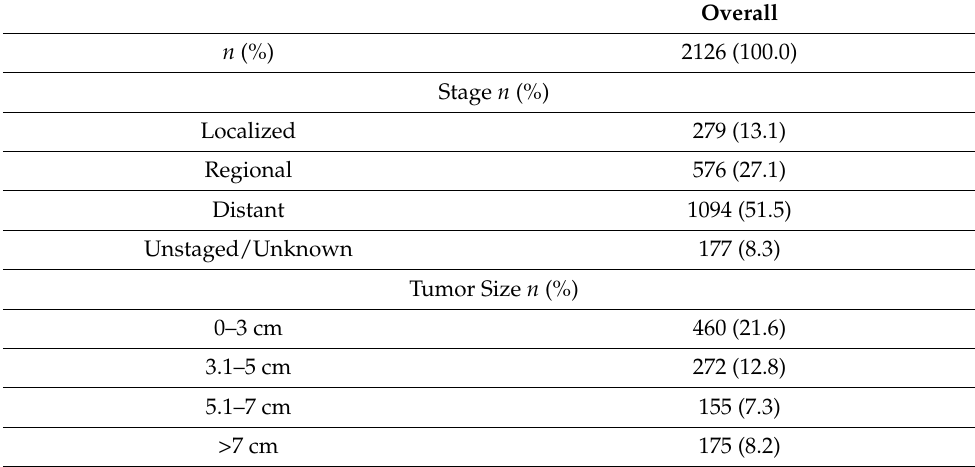
Table 2. Tumor Characteristics of 2126 Patients with Combined Small-Cell Lung Cancer from Surveillance Epidemiology and End Result (SEER) Database (2000–2018).